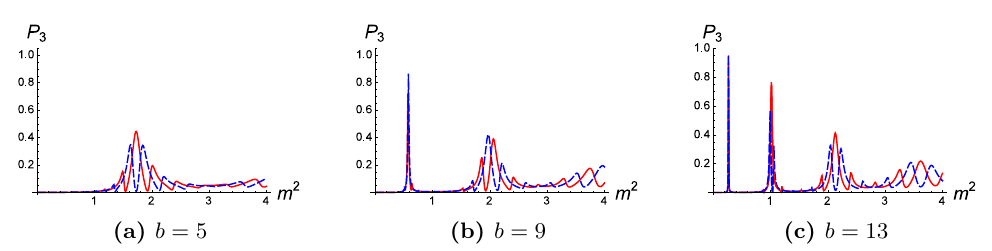
Figure 11. The relative probability P 3 ( m 2 ) of the even parity mode t e ( z ) (red solid lines) and the odd parity mode t o ( z ) (blue dashed lines) for the double brane model (3.8). The parameters are set to k = 1 and d = 2 : 3.